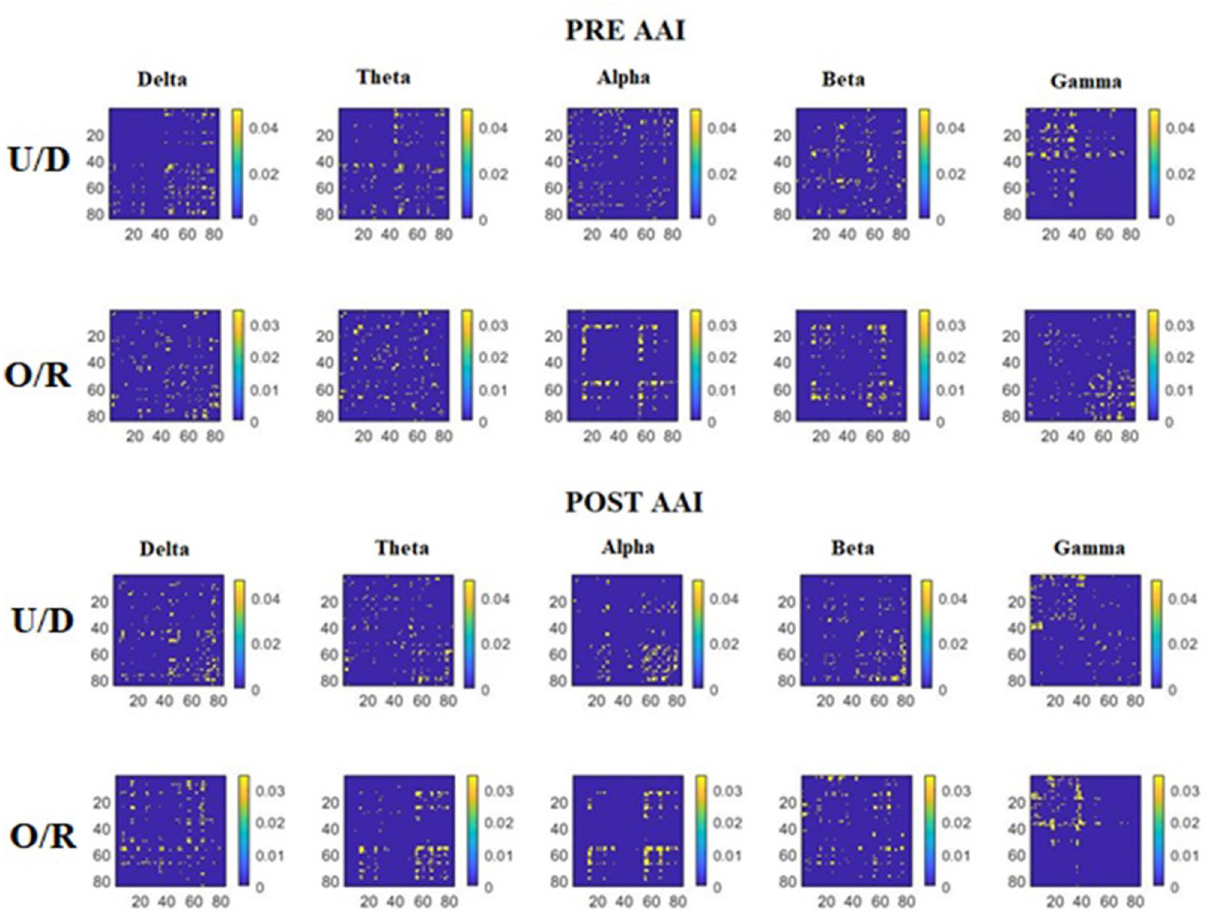
Figure 2. Averaged network matrices for all standard frequency bands (i.e., delta, theta, alpha, beta and gamma) for both conditions (i.e., pre AAI and post AAI), for both groups (i.e., U/D